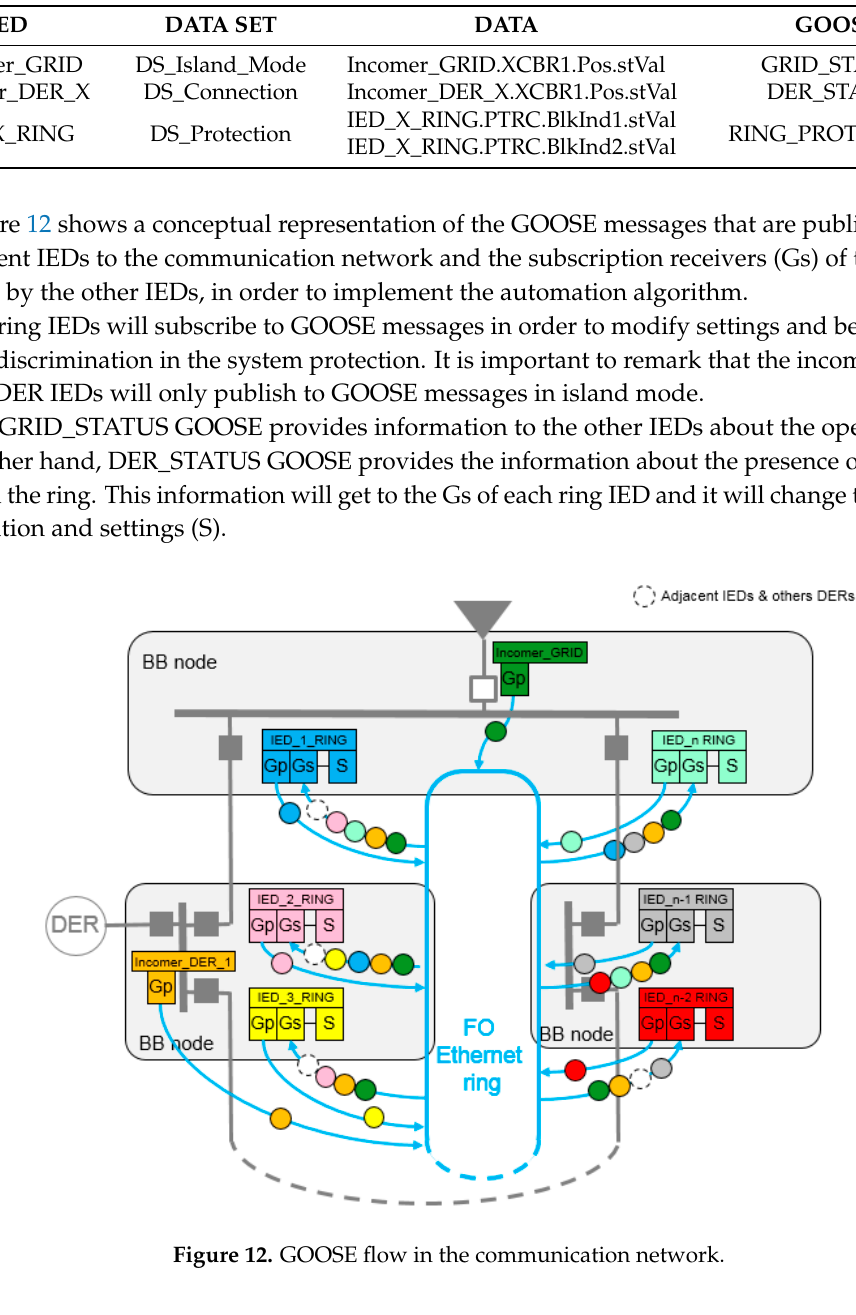
Figure 13. GOOSE publication and subscription between several IEDs. GOOSE sequence: 1. (goID)GRID_STATUS IED_GRID/LLN0$GO$GRID_STATUS